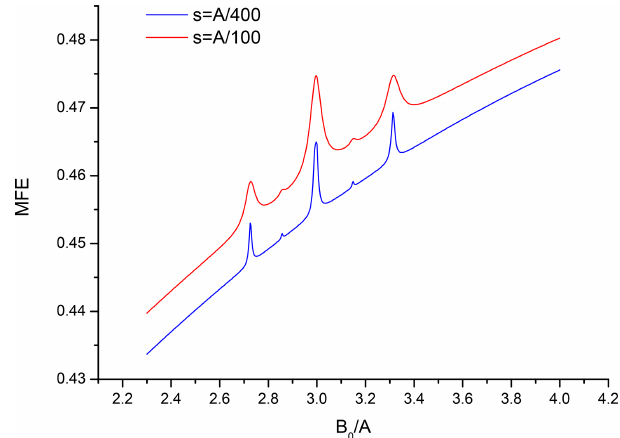
Figure 1. The review MFE curve for a pair with six equivalent spin- 1 nuclei with HFC constant A in one partner and two equivalent 2 spin- 1 nuclei with HFC constant A/ 10 in the second partner, re- 2 combination parameter s = A/ 100.